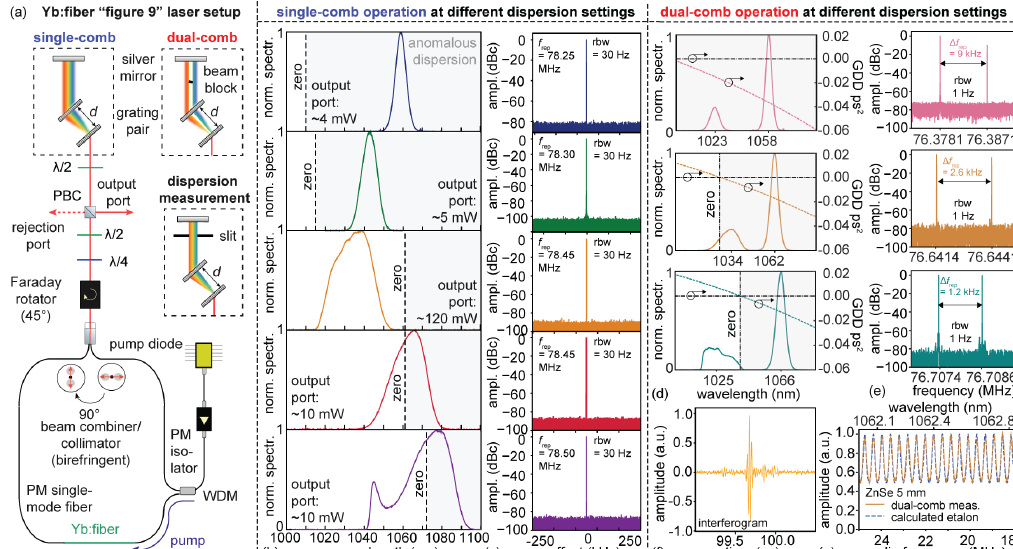
Figure 1: (a) Laser setup depicting the single- and dual-comb operation mode as well as the slit-method used for intra-cavity dispersion measurements. (b) Optical spectra of modelocking states obtained in single-comb operation at 5 different grating separations d and (c) corresponding measurement of the repetition rate frequency f rep . (d) Optical spectra in dual-comb operation at 3 different grating separations and (e) corresponding measurement of the repetition rate frequencies f rep,1 an f rep,2 . (f) Single-shot time domain interferogram of the configuration with Δ f rep =2.6 kHz corresponding to (g) transmission measurement of a 5-mm thick ZnSe (orange) and simulation